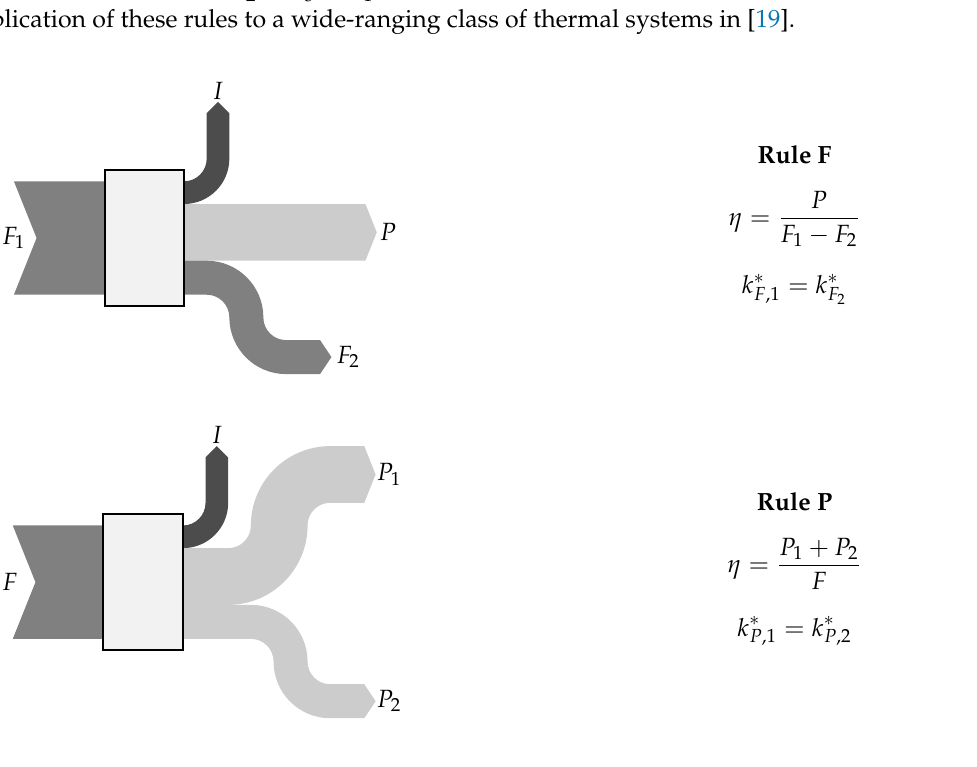
Figure 1. Cost allocation rules F and P in stream